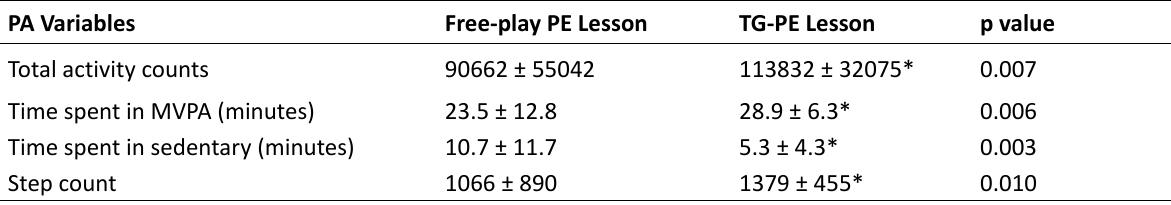
Table 2 . Comparison of Physical Activity Variables between Free-Play PE Lesson and TG-PE Lesson (Mean ± SD) PA Variables